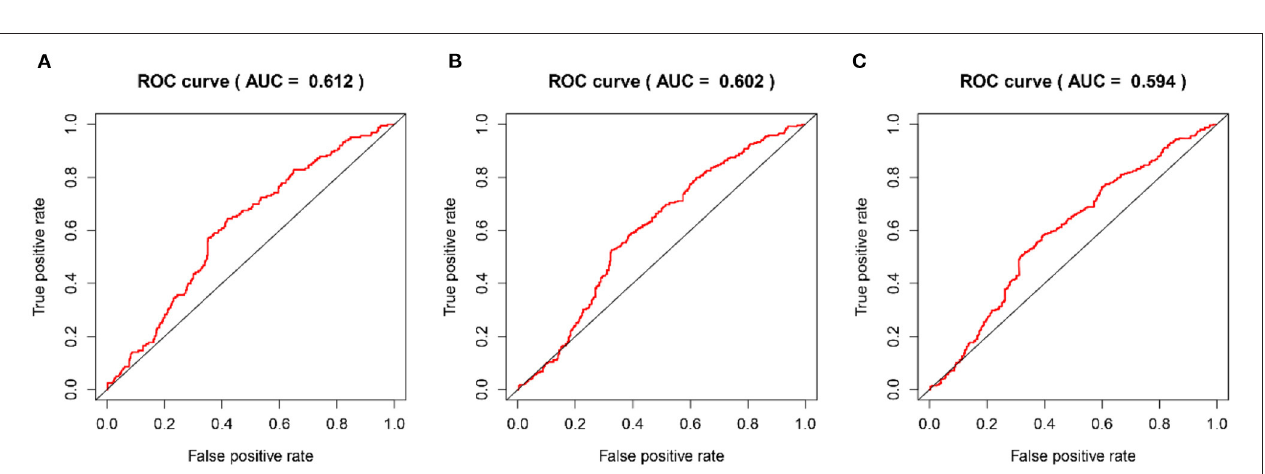
FIGURE 4 | The time-dependent ROC curves in the TCGA training cohort. (A–C) ROC curves to evaluate the predictive accuracy of the model for OS at 1-, 2-, and 3-years in the TCGA training cohort.